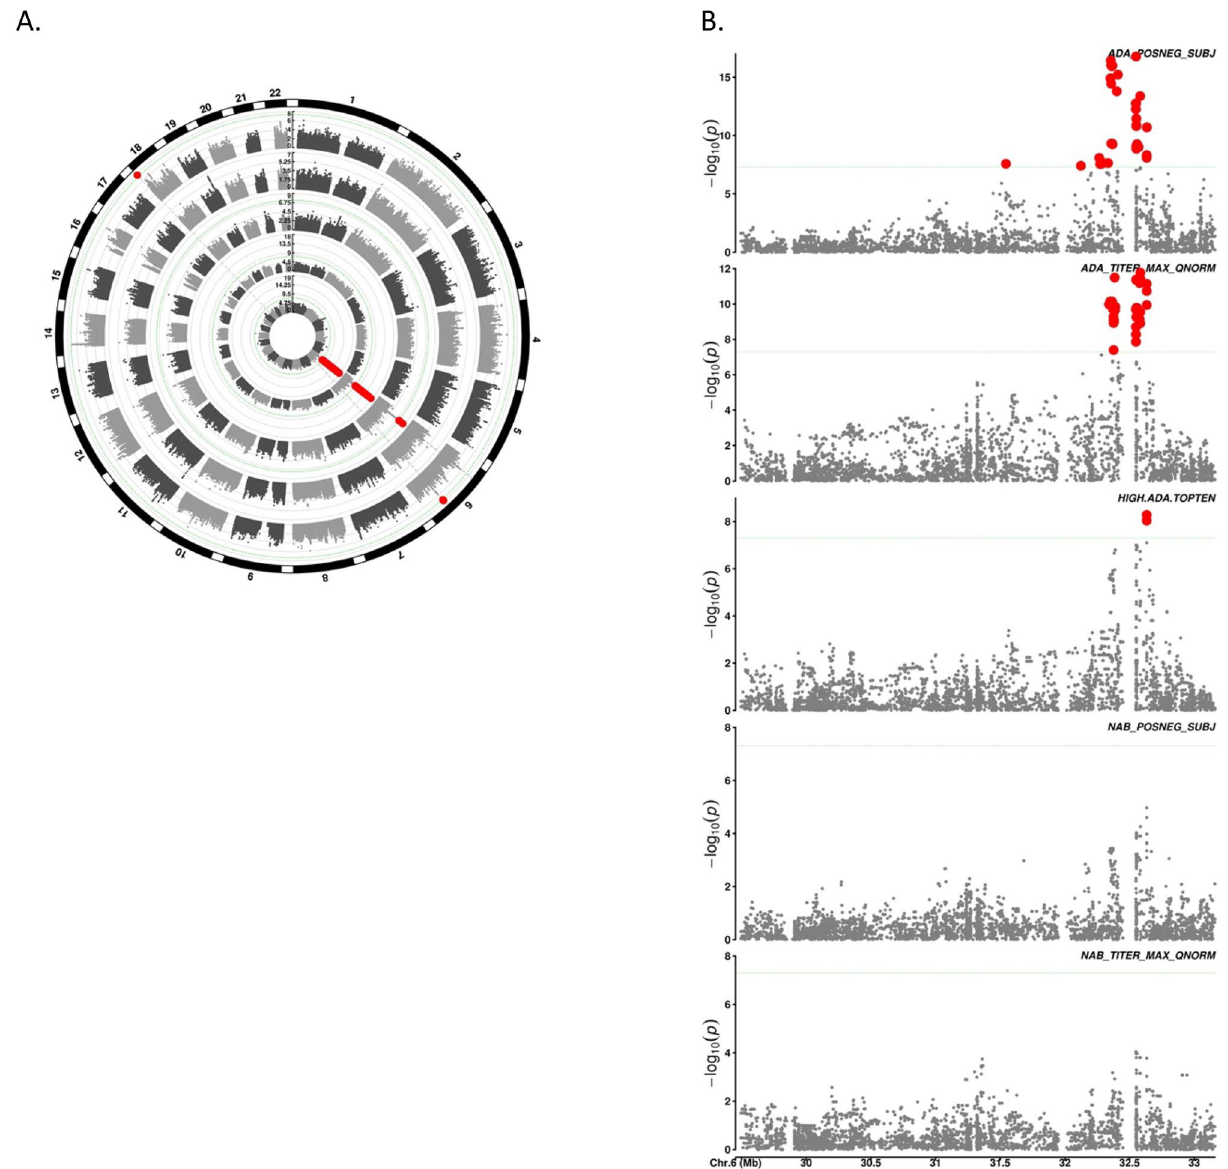
Figure 1. Genome-wide associations with anti-drug antibody response to bococizumab in SPIRE. ( A ) Circular Manhattan plot of genome-wide associations using genome-wide genotype data imputed to the HRC reference panel. Each ring corresponds to an anti-body response phenotype ordered from the central ring toward the perimeter as ADA positive, ADA maximum titer, ADA maximum titer top 10%, NAb positive, NAb maximum titer (see “Methods”). Thin green dashed lines indicate genome-wide significance threshold (p = 5 × 10 –8 ) for each genome-wide scan. Red dots indicate SNPs reaching genome-wide significance. See Supplementary Figure S1 for corresponding quantile–quantile (QQ) plots. ( B ) Manhattan plot restricted to the MHC region (chr6:29-33 Mb) derived from MHC-specific imputation. Antibody response phenotypes as indicated are in the same order, top to bottom, as phenotypes in ( A ) center to perimeter. Thin green dashed line and red dots as in ( A